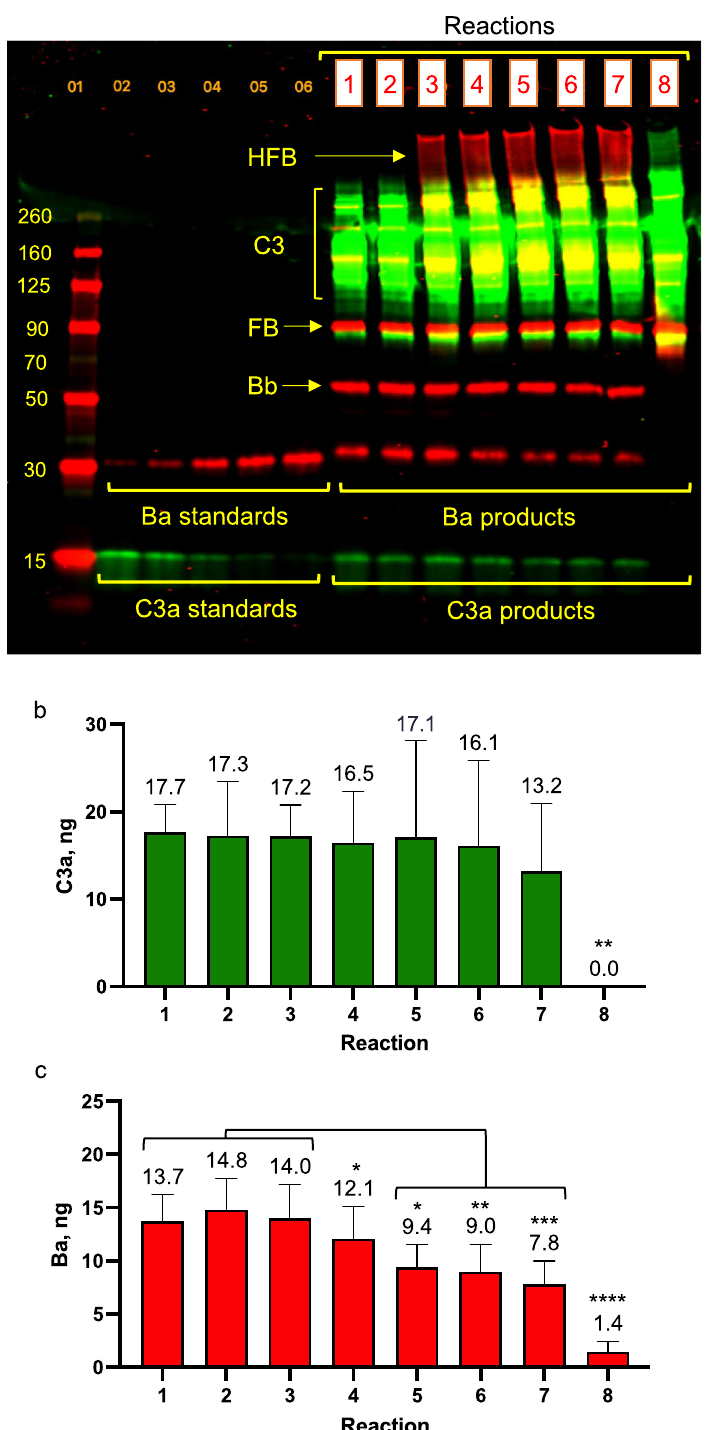
Figure 3. HFB inhibition of AP activation in FH-D serum (with low FH). AP activation was measured by Western blot analysis in FH-D serum (supplemented with 3.13 ng/µl of FH) after the addition of increasing concentrations of HFB. FH was not added to FH-D serum in control reactions 1, 7 and 8. ( a ) The representative Western blot shown is the merged detection of C3a (using rabbit anti-C3a + donkey anti-rabbit IRDye-800, green) and Ba (using goat anti-FB + donkey anti-goat IRDye-680, red). The protein ladder is in lane 1, C3a and Ba standards are in lanes 2–6, and the reaction samples (labeled with boxed numbers 1–8) are in lanes 8–14. The extent of AP activation was measured after 5 min at 22 °C and analyzed for ( b ) C3a and for ( c ) Ba, in 4 experiments. In ( a ), C3a levels measured in the absence of FD were significantly lower than levels measured in the other reactions (1 vs. 8, P = 0.0016; 2 vs. 8, P = 0.0025; 3 vs. 8, P = 0.0021; 4 vs. 8, P = 0.0033; 5 vs. 8, P = 0.0022; 6 vs. 8, P = 0.004; 7 vs. 8, P = 0.0246). In ( b ), Ba levels in reactions 5, 6 and 7 were statistically lower than Ba levels in reactions 1–3; (1 vs. 5, P = 0.0154; 1 vs. 6, P = 0.007; 1 vs. 7, P = 0.0006; 2 vs. 5, P = 0.0016; 2 vs. 6, P = 0.0008; 2 vs. 7, P < 0.0001; 3 vs. 5, P = 0.0079; 3 vs. 6, P = 0.0035; 3 vs. 7, P = 0.0003) and levels in reaction 7 were statistically lower than reaction 4 levels (P = 0.0163). In the absence of FD, the measured levels of Ba were lower than levels in each of the other reactions (1–6 vs. 8, P < 0.0001; 7 vs. 8, P = 0.0003). Statistics were analyzed by 2-way ANOVA with Tukey’s multiple comparisons test and were summarized on graph (*P < 0.05, **P < 0.005, ***P < 0.0005, ****P <